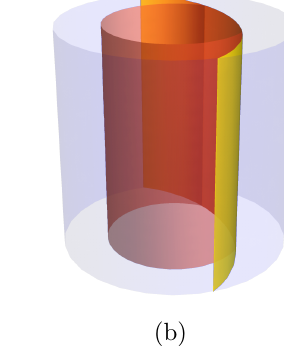
the midpoint ρ = µ, σ = 0 , and the string makes a complete circuit of the azimuthal circle. On the other hand, increasing α we again find the string expands out toward the Ads 3 boundary, which it reaches as α → 1 ; as it does so, the total amount of winding decreases until at α = 1 it again winds halfway around AdS 3